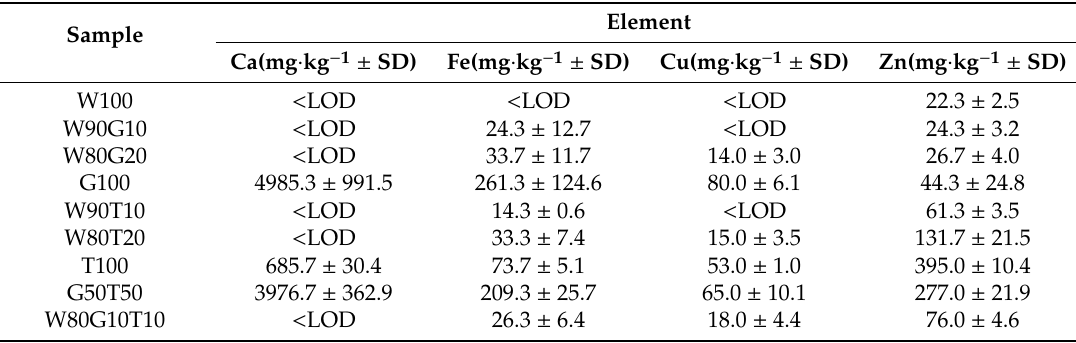
Table 2. Representation of elements in wheat flour, grape pomace flour, and mealworm larvae